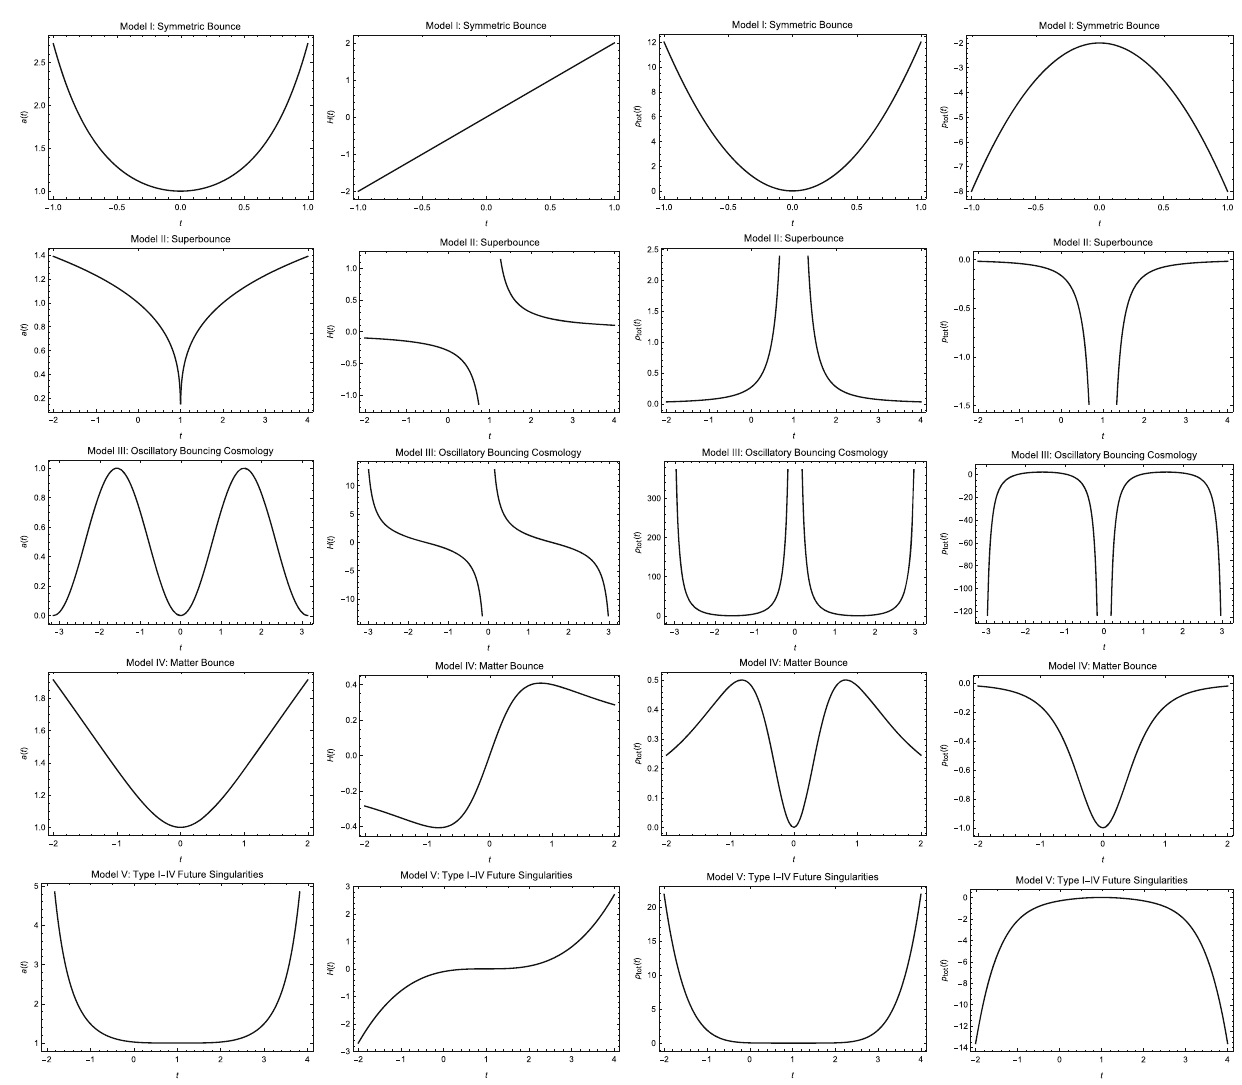
Fig. 1 For each bouncing scenario analyzed in this work, we plot rep- resentative graphs of their scale factor and Hubble parameter, as well as their total density and pressure contributions. The bouncing charac-